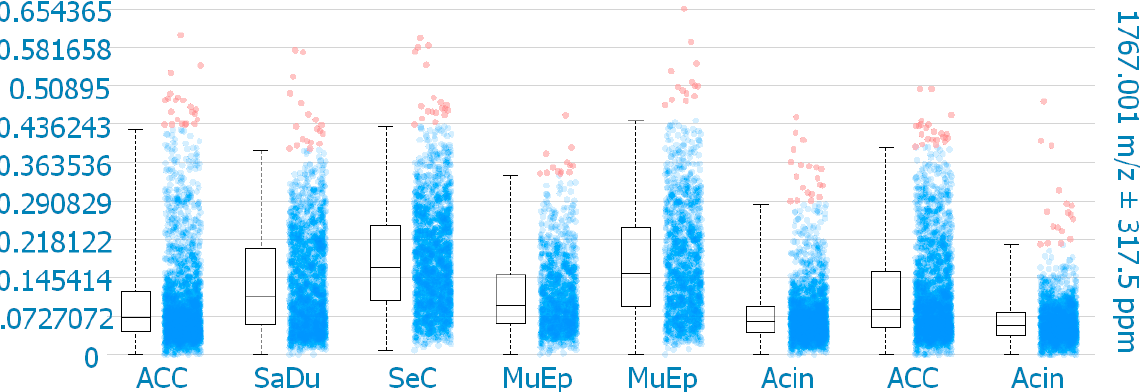
Figure 6. CD138 expression using MALDI-MS imaging. Box plots comparing the mean intensities of the m / z value of all detected CD138 peptide masses per pixel in the corresponding TMA cores. ACC = Adenoid cystic carcinoma, SaDu = Salivary duct carcinoma, SeC = Secretory carcinoma, MuEp = Mucoepidermoid carcinoma, Acin = Acinic cell carcinoma.